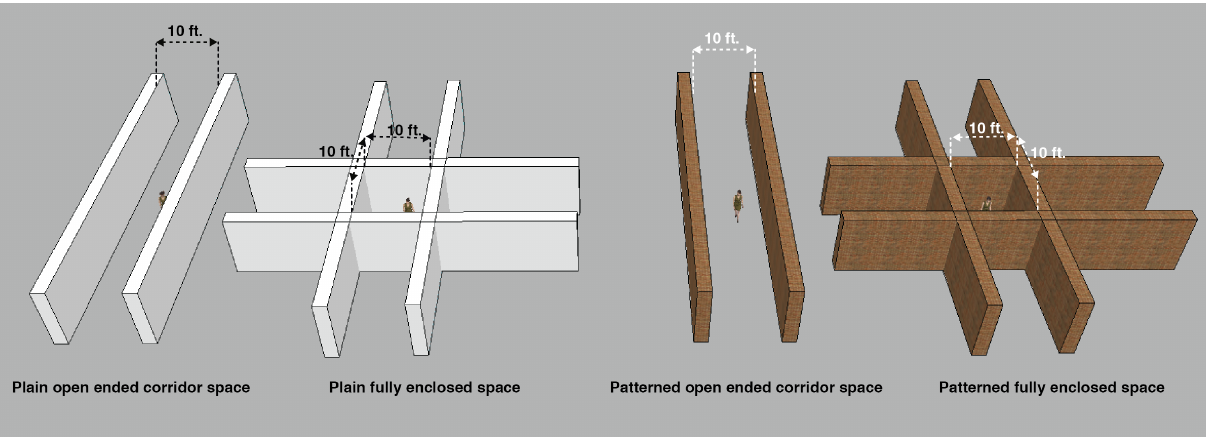
Figure 2. Experiment setup schema and view types used in each system.